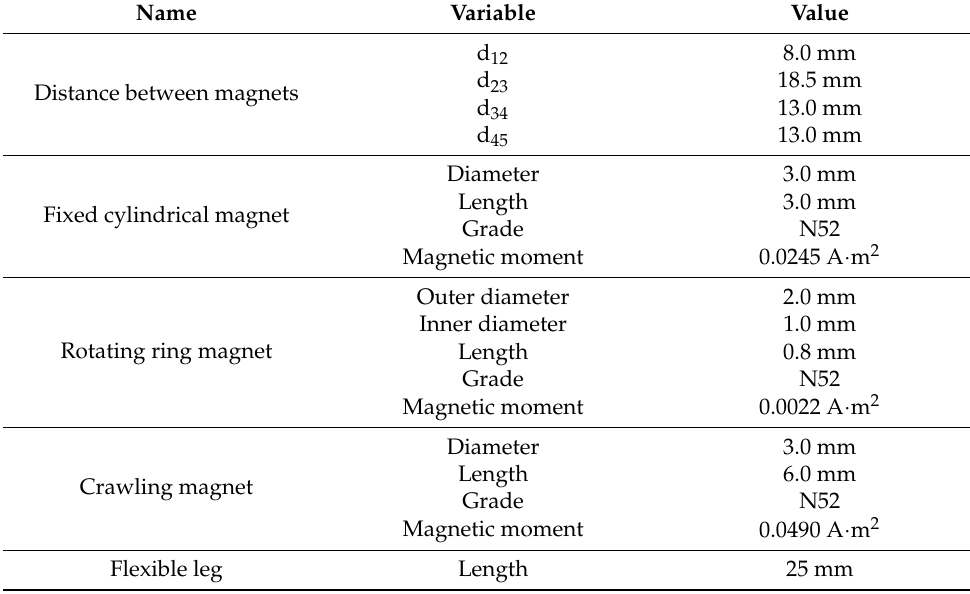
Table 1. Design variables of the